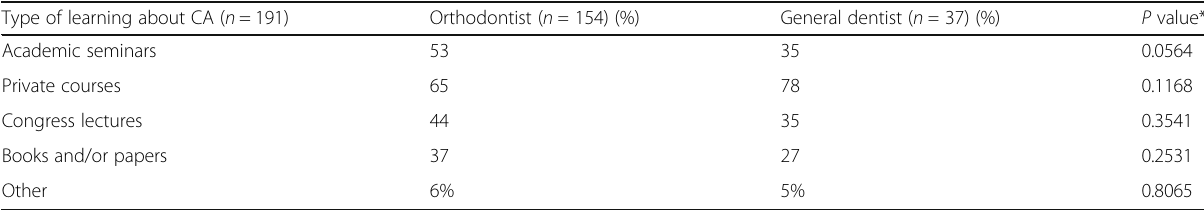
Table 3 Comparison between orthodontists and general dentists in learning about the use of CA Type of learning about CA ( n = 191) Orthodontist ( n = 154) (%) General dentist ( n = 37) (%) P